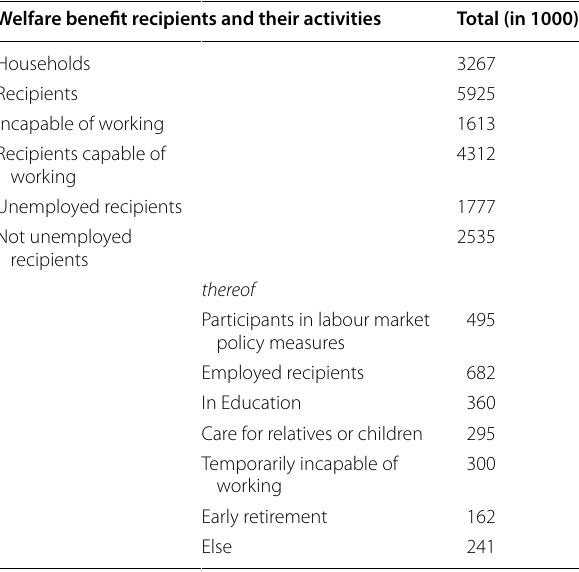
Table 1 Welfare benefit recipients and their activities